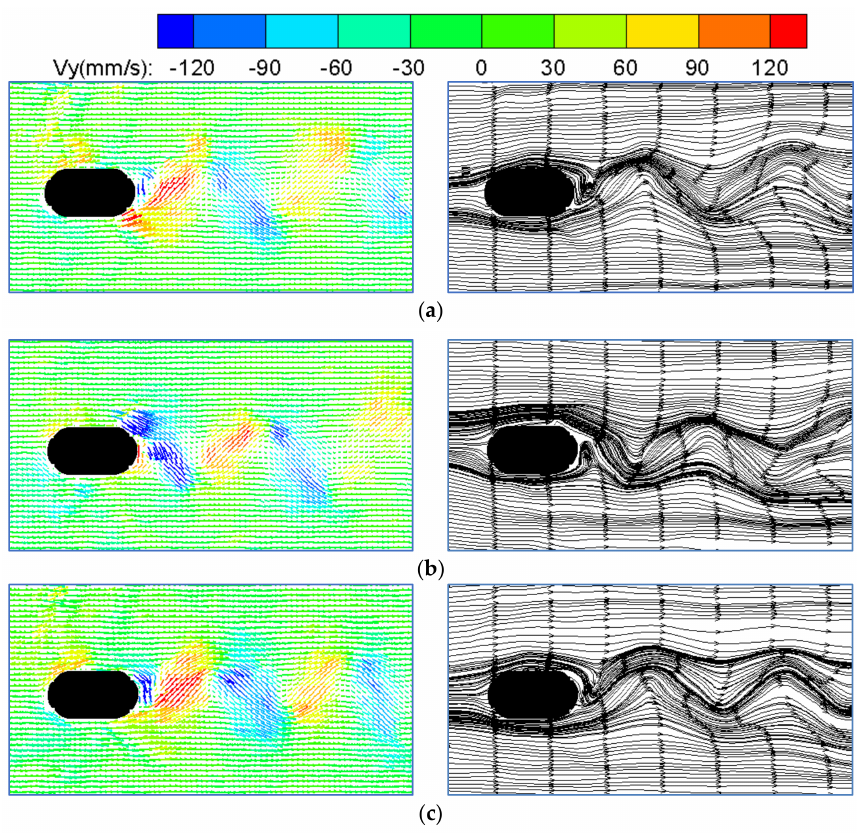
Figure 4. Instantaneous velocity vector diagram and flow diagram of the round-ended pier with α = 0: ( a ) T = 0 s; ( b ) T = 0.387 s; ( c ) T = 0.780 s.